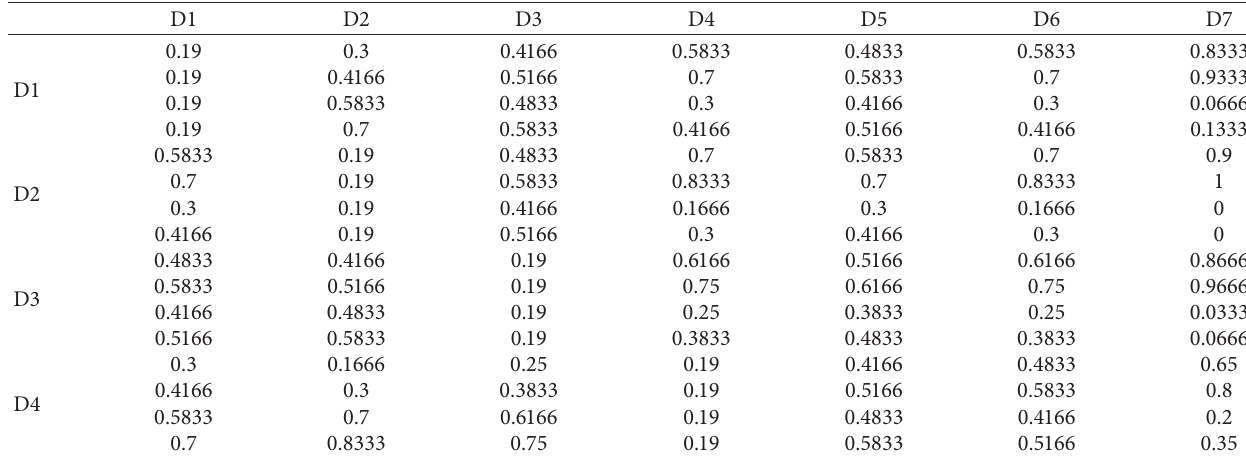
Table 11: Pairwise comparison of main